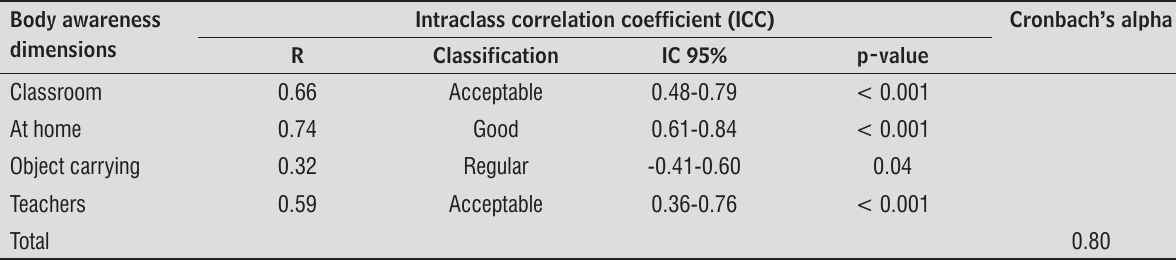
Table 5 - Analysis of the intraclass correlation coefficient